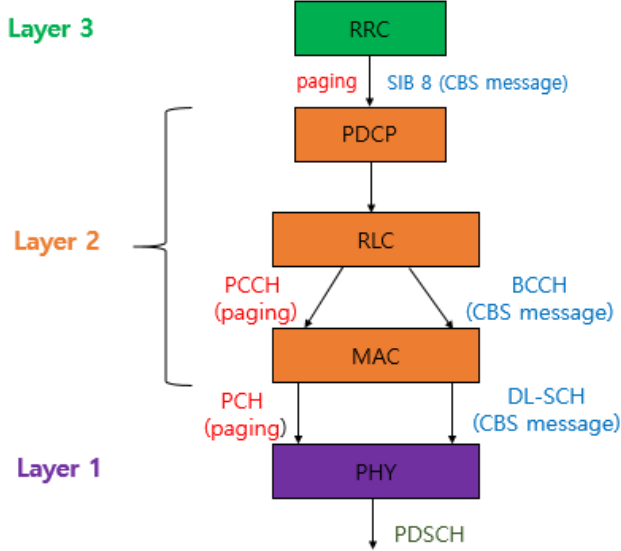
Figure 3. The radio protocol of the base station for 5G